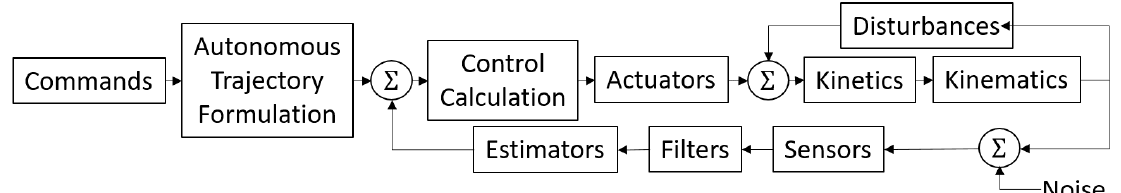
Figure 1. The system topology from commanded end-state and time, through autonomously calculated desired roll φ d , pitch θ d , and yaw ψ d inputs, through control calculations executed by control moment gyroscope actuators resulting in actual Euler angle outputs of kinematic expressions of kinetic responses. Notice that actual responses are unknown, but sensed and filtered, and then used in state estimators to provide full state feedback.